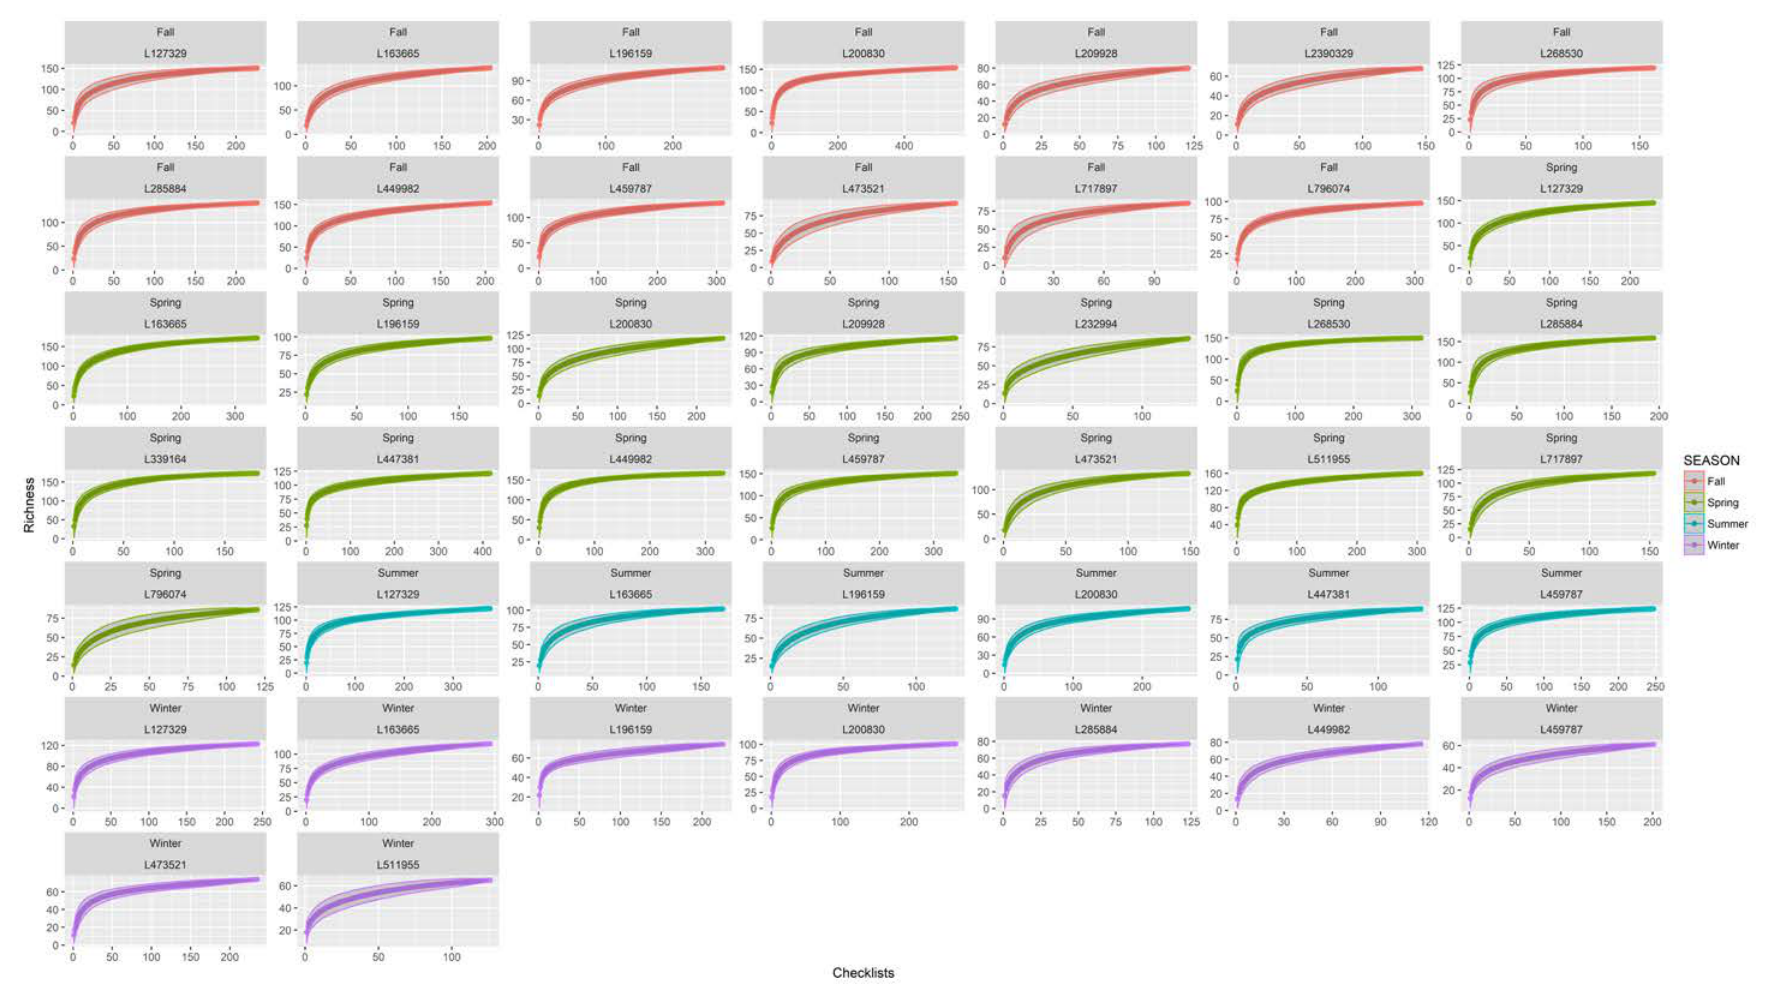
Figure A2.4. Species richness accumulation curves for each hotspot/season combination that had >100